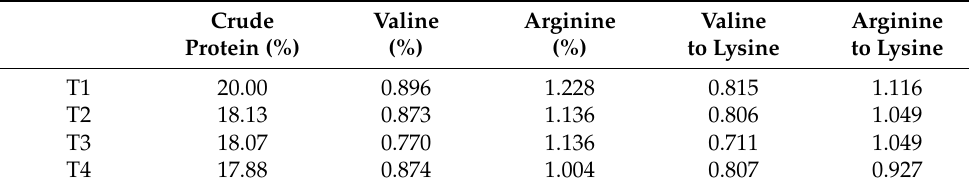
Table 1. Analyzed levels of crude protein, valine and arginine, valine to lysine ratio and arginine to lysine ratio in the different dietary treatments (T1 to T4). Crude Valine Arginine Valine Arginine Protein (%) (%) (%) to Lysine to Lysine T1 20.00 0.896 1.228 0.815 1.116 T2